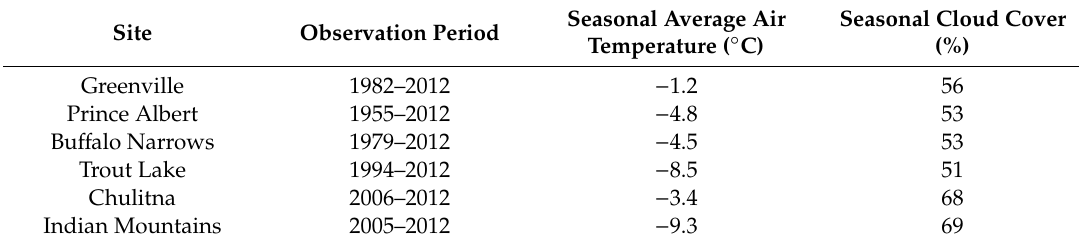
Table 2. Climatological characteristics of the study